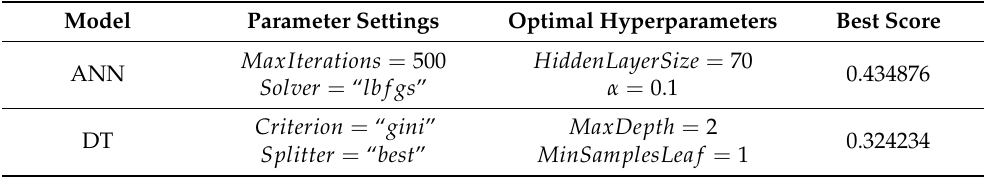
Table 5. The optimal hyperparameters of the seven models.